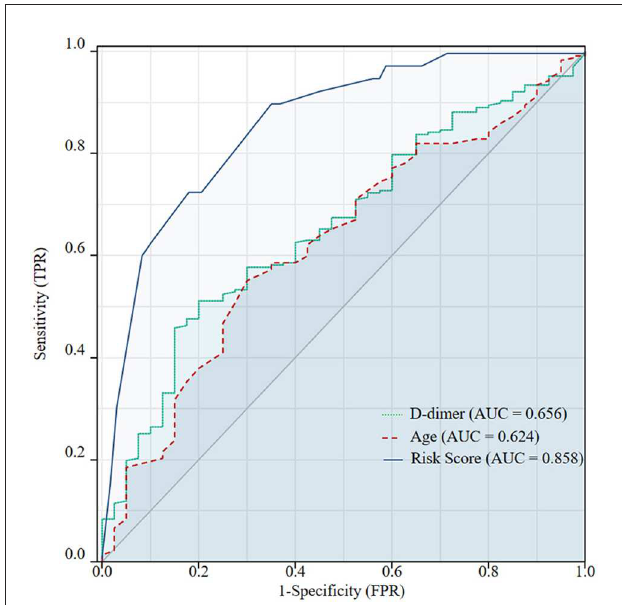
FIGURE2 Receiver operating characteristic (ROC) curves were used to identify the optimal cutoff values of age and D-dimer for inferior vena cava thrombosis (IVCT) in patients with lower extremity deep vein thrombosis (DVT). The cutoff values were 63.5 years and 4.72 µ g/ml, respectively. The AUC of the ROC for age < 63.5 years was 0.624 (95% CI, 0.533–0.715) and 0.656 (95%CI, 0.571–0.742) for a D-dimer value > 4.72 µ g/ml. Predicted probabilities of IVCT according to the combined five features: age < 63.5 years, male sex, proximal DVT, bilateral DVT, and D-dimer > 4.72 µ g/ml. The AUC of the ROC was 0.858 (95% CI, 0.799–0.916). The diagnostic efficiency of this multivariable model was significantly better than a single risk factor of age < 63.5 years ( p < 0.001) or D-dimer > 4.72 µ g/ml ( p < 0.001)